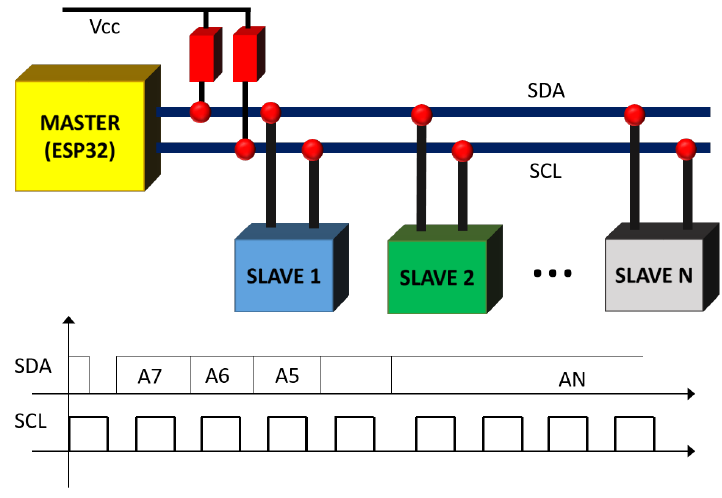
Figure 4. A typical I 2 C chain and waveforms: one master and several slaves. The connection hardware needed is reduced to two pull-up